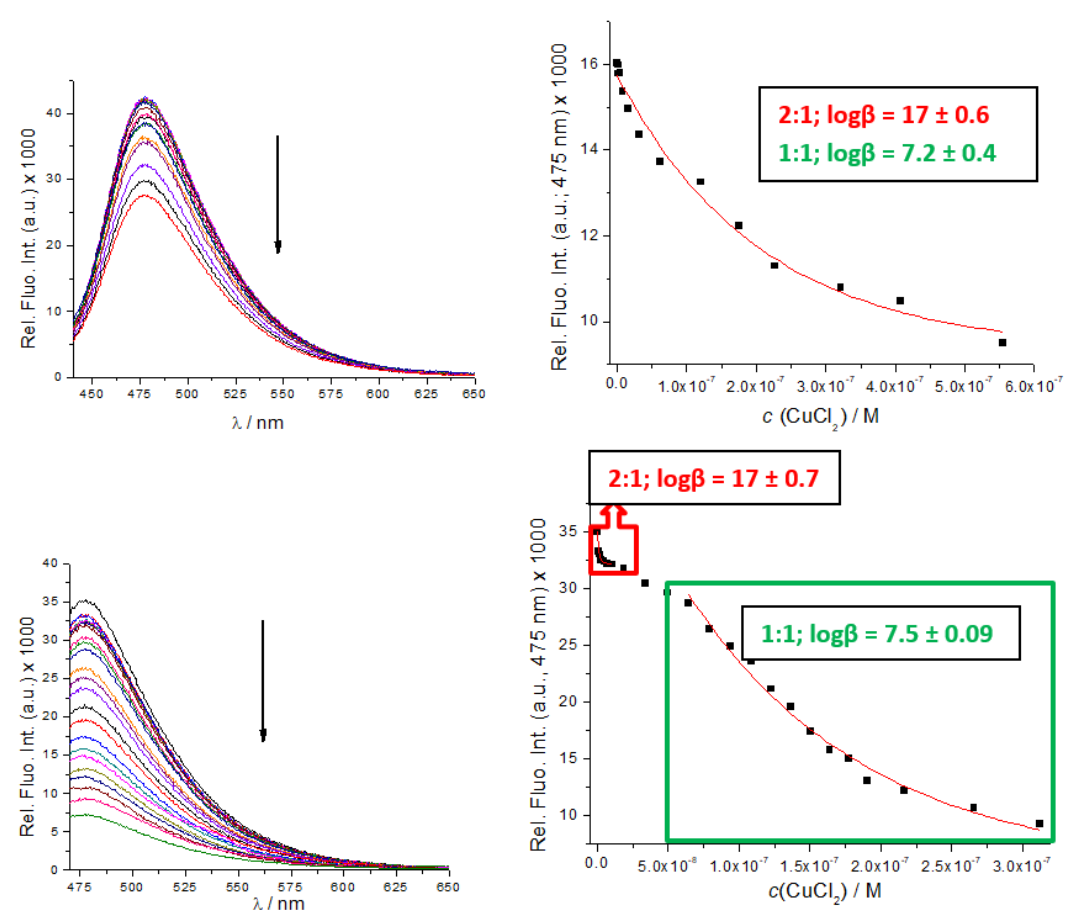
Figure 3. Fluorimetric titrations of B-boc ( up ) and B ( down ) ( c = 1 × 10 − 8 M; λ exc = 353 nm) with CuCl 2 . RIGHT: dependence of fluorescence at λ max = 475 nm on c (CuCl 2 ). Done at pH 7, sodium cacodylate buffer, c = 50 mM.